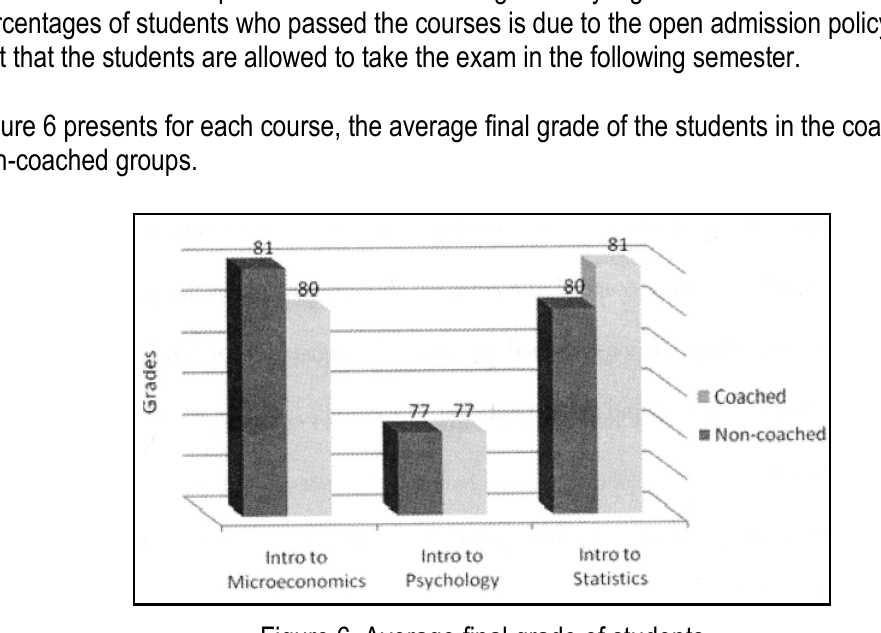
Figure 6. Average final grade of